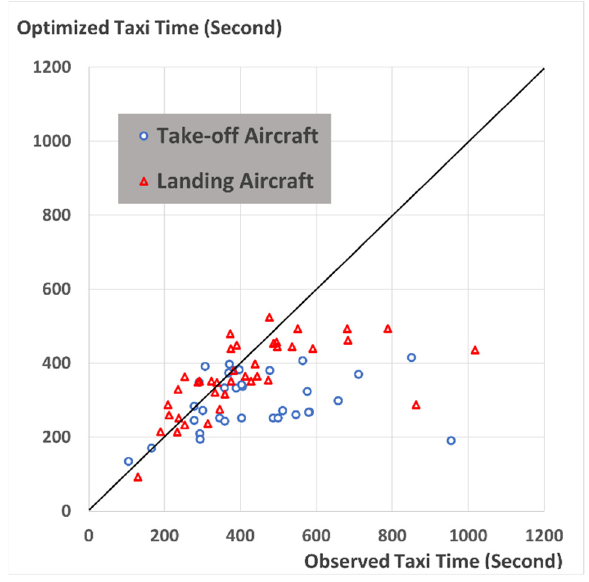
Figure 11. Result comparison of total taxi time without runway reselection.